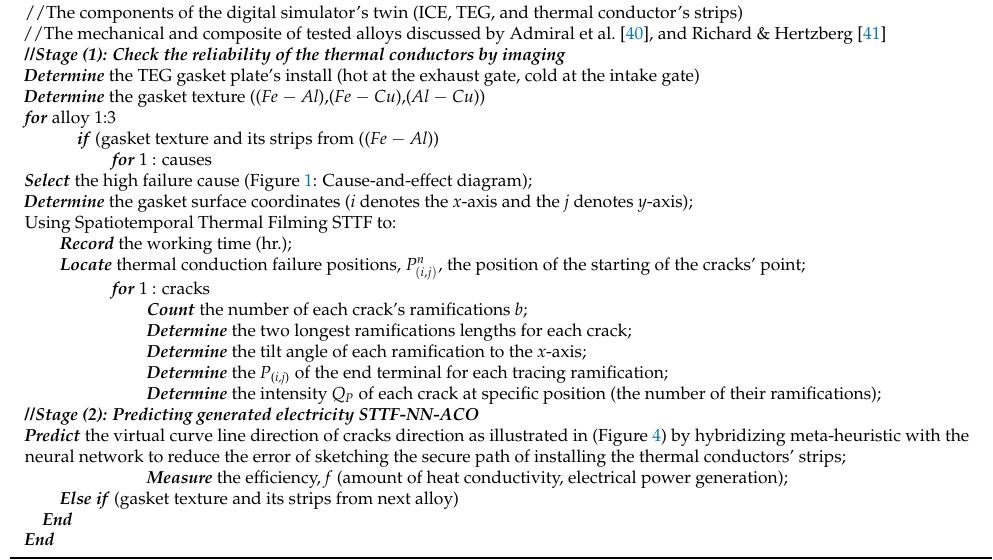
Algorithm 1: Main Pseudocode of STTF-NN-ACO mechanism